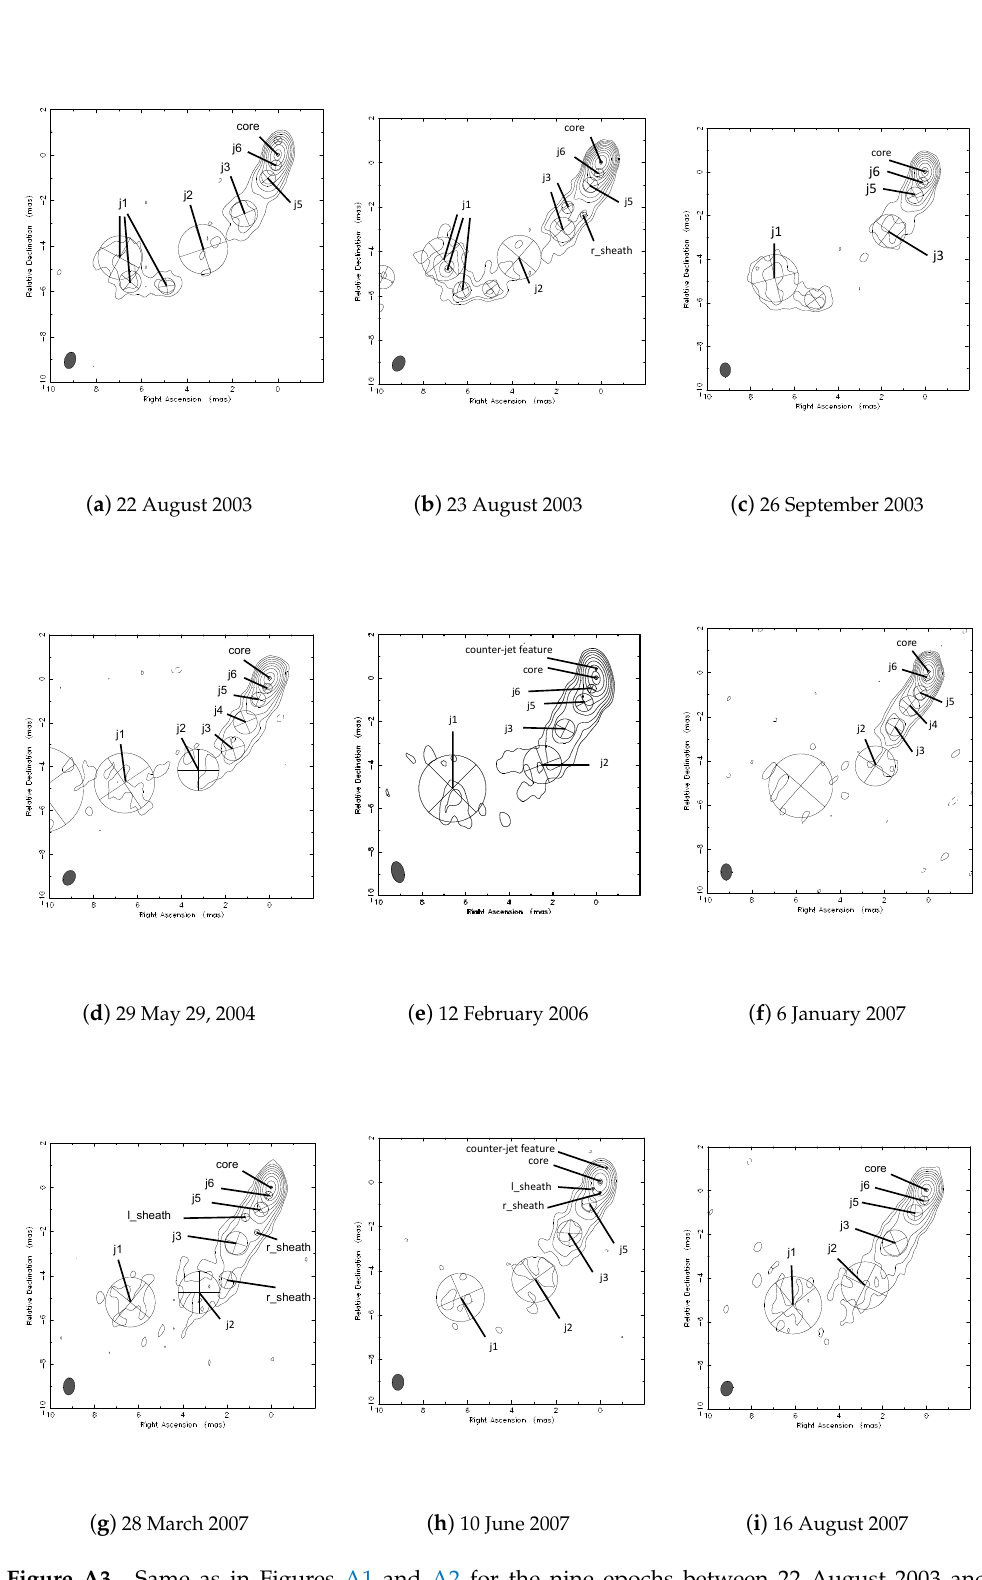
Figure A3. Same as in Figures A1 and A2 for the nine epochs between 22 August 2003 and 16 August